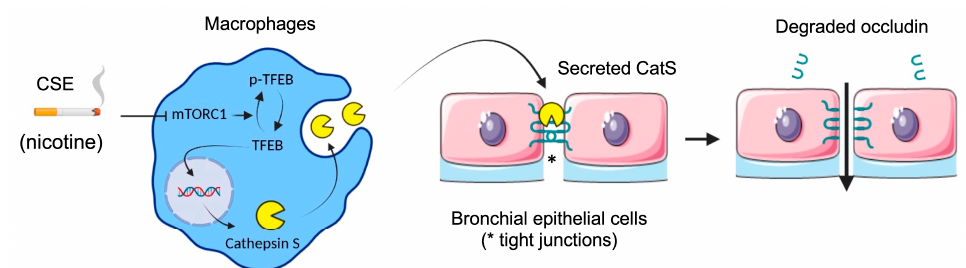
Figure 10. Proposed mechanism of cigarette smoke-induced increase in lung epithelial cell permeability (synthetic graphic). Cigarette smoke triggers upregulation of CatS by macrophages through the mTOR/TFEB signaling pathway. CatS overexpression was driven by nicotine, a major chemical of cigarette smoke. Consequently, secreted active CatS could proteolytically damage occludin, leading to impaired integrity of the epithelial barrier. Figure prepared with BioRender (https://biorender.com/, accessed on 2 April 2021).